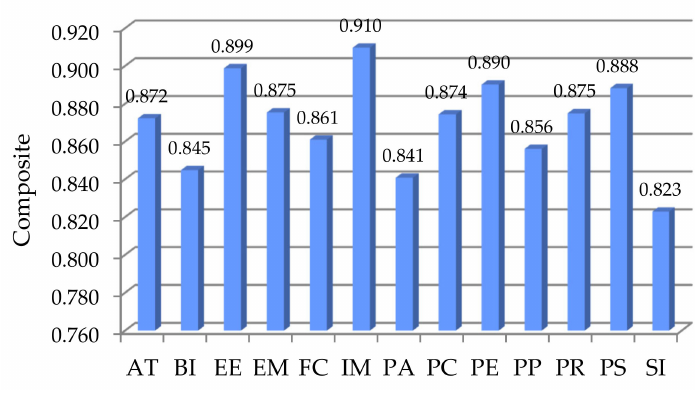
Figure 4. Composite